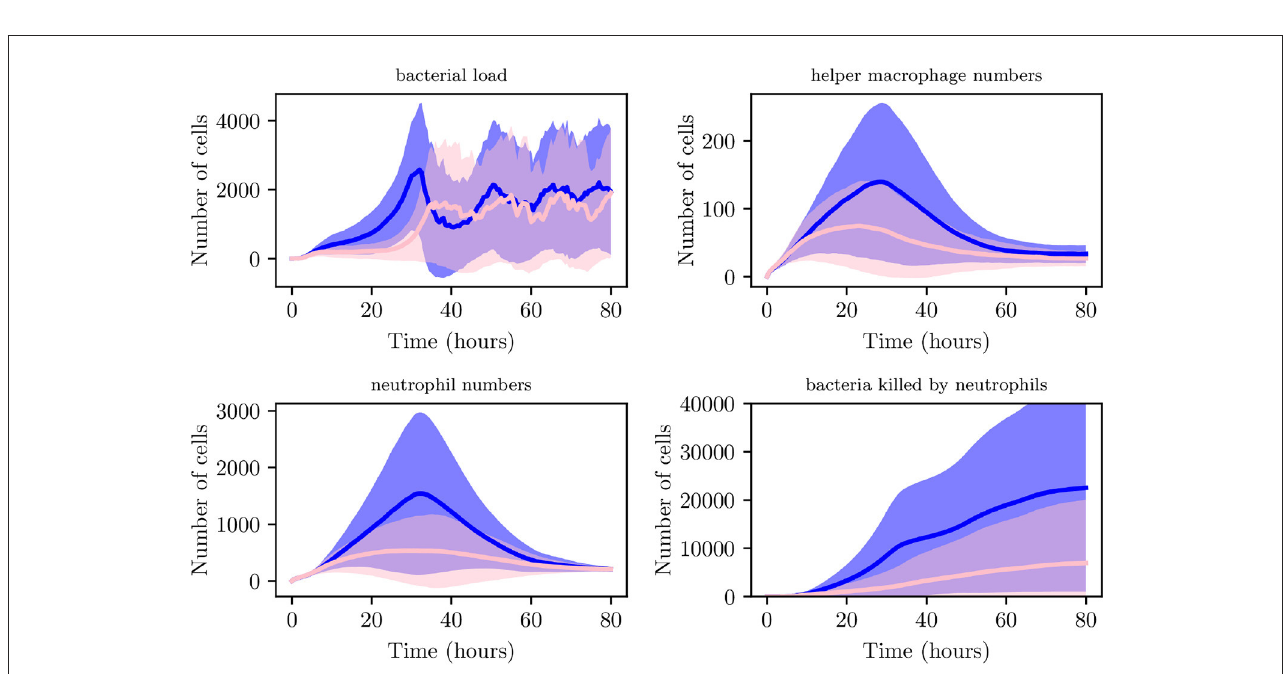
FIGURE13 Average values for bacterial load, helper macrophage load, neutrophil load and bacteria killed by neutrophils. Simulations for the immunocompromised environment in pink and the non-immunocompromised environment in blue, with 95 % confidence intervals shown by the shaded regions.